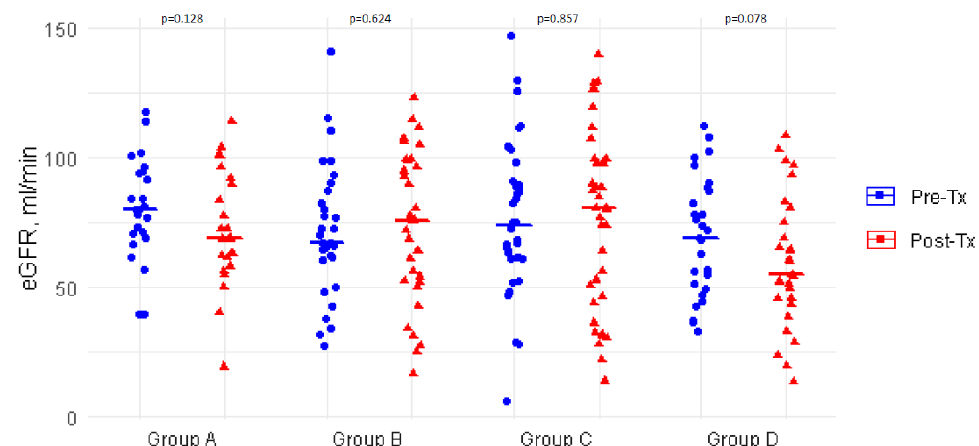
Figure 2. Column scatter plot showing changes in the estimated glomerular filtration rate from pre-transplant to post-transplant assessment in patients grouped according to changes in glucose metabolic state. Group A: worsened, including PTDM (N = 23); group B: improved (N = 31); group C: persistently normal glucose metabolism (N = 36); group D: unchanged pre-diabetes/DM (N = 29). Mortality was significantly different according to post-transplant glucose metabolic changes. In particular, early mortality was lower in group C patients (stably normal), whereas improvement of glucose metabolic state after transplant (group B) favorably affected mid-term mortality, which was indeed better than in group D where glucose metabolism remained altered (log-rank p = 0.028; Figure 3). Survival in the overall study sample (all subgroups) was also analysed in a logistic regression model in relation to all major clinical risk factors before and after transplant, as well as all variables related to glucose metabolism (Supplementary Table S2). As shown, none of the evaluated factors was an independent predictor of mortality in the multivariable analysis. No differences were observed across the 4 groups regarding risk of infections and cancer development (not shown).